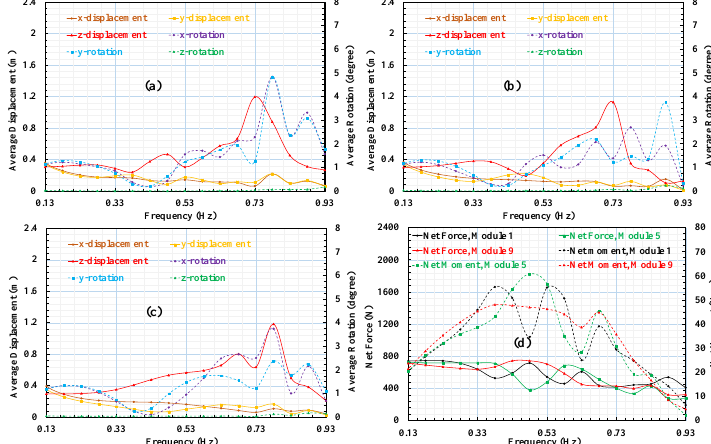
Figure 11. Average displacement of ( a ) module 1, ( b ) module 5, ( c ) module 9, and ( d ) net forces and moments corresponding to 135° of the wave direction .